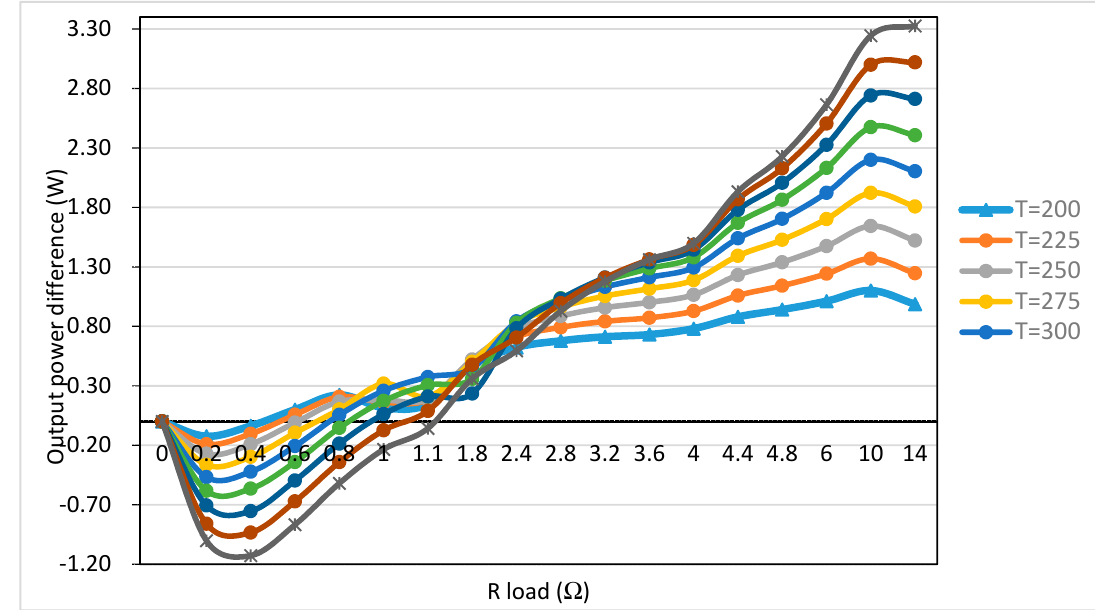
Figure 17. The output power difference between ESC and P&O based models.